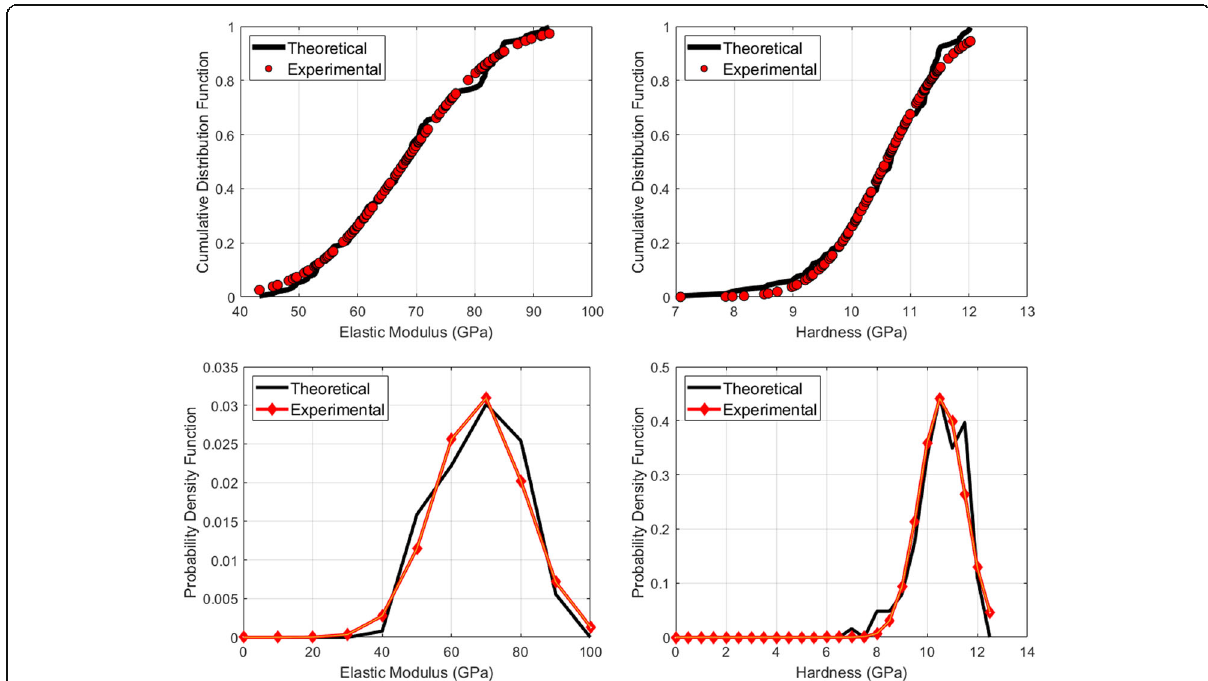
Fig. 1 Statistical Indentation Analysis; Top - cumulative distribution functions (CDF), Bottom – probability density function of elastic modulus (left) and hardness (right)